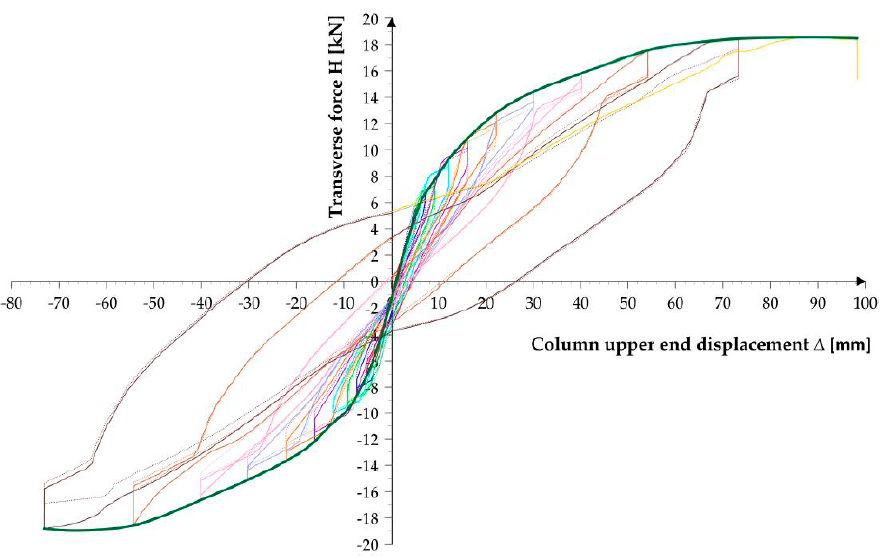
Figure 12. Hysteresis cycles in one of the specimens.